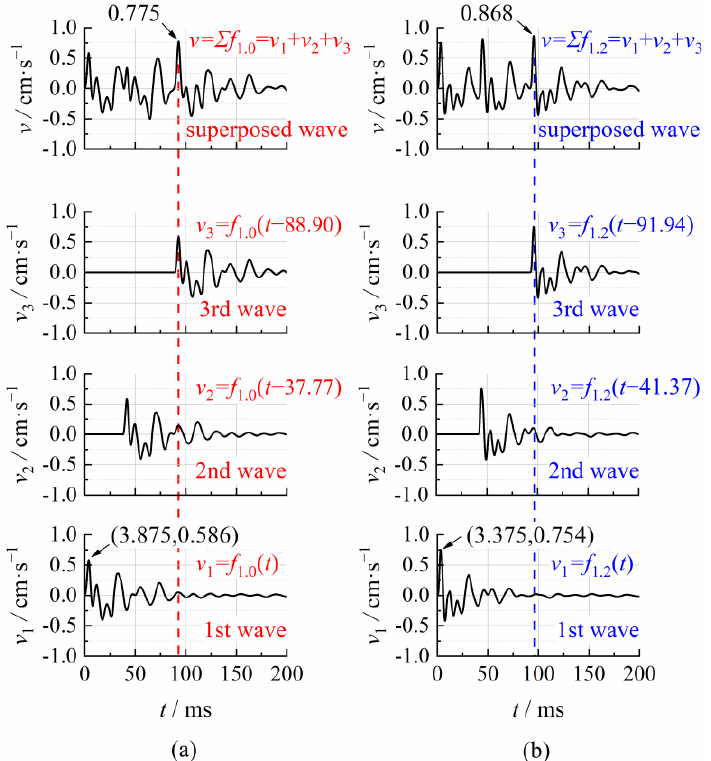
Figure 12. Single-hole waves and superposition process: ( a ) superposition of three waves (each hole had 1.0 kg of explosives); ( b ) superposition of three waves (each hole had 1.2 kg of